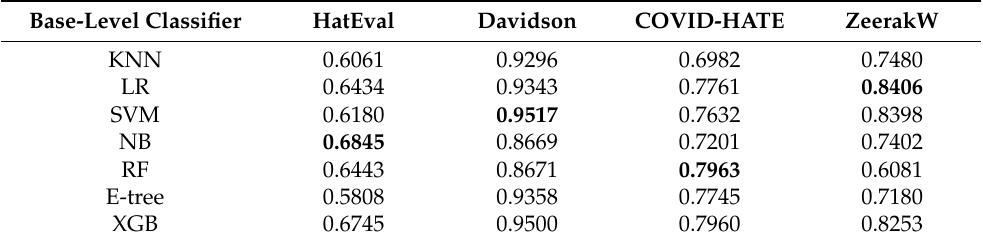
Table 6. F1-score of the Base-Level classifiers on the development set. Bold entries show the highest performance for each classifier on each dataset.